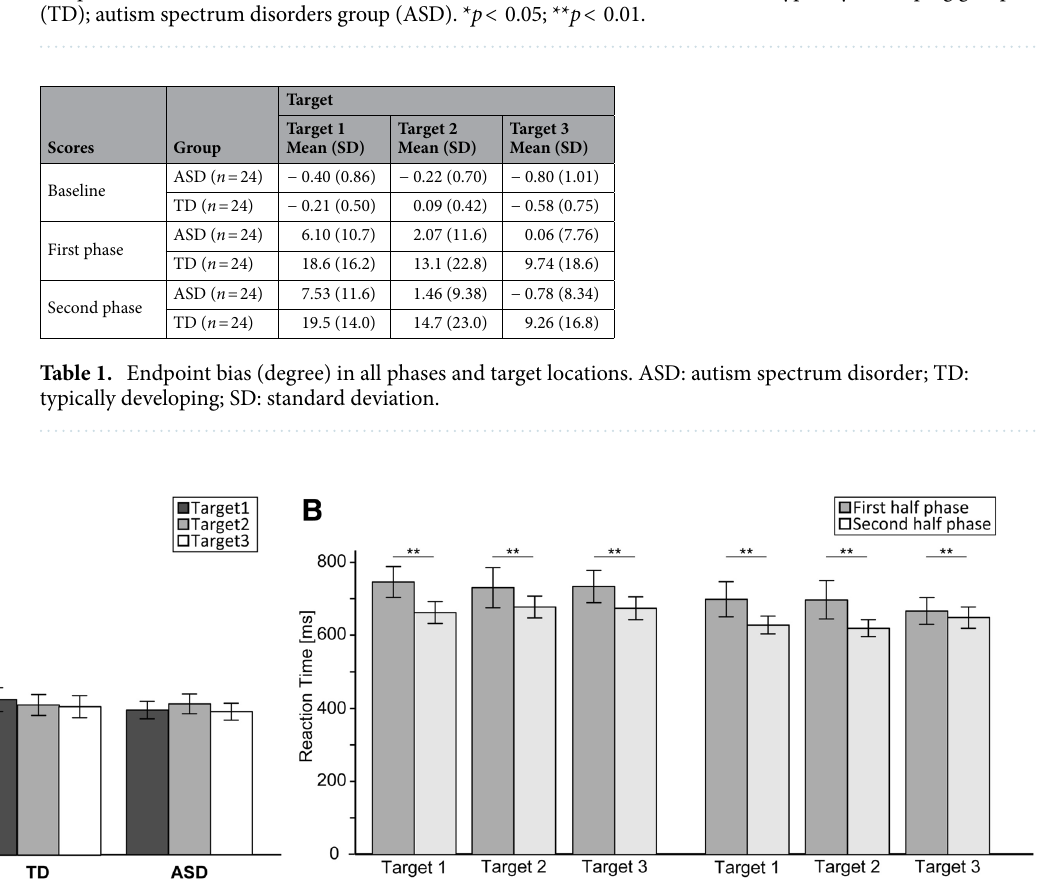
Figure 1. The endpoint bias (degree) in both the TD and ASD groups for both the Baseline task ( A ) and Perspective-transformed task ( B ). Error bars indicate standard errors of the mean. Typically developing group (TD); autism spectrum disorders group (ASD). * p < 0.05; ** p < 0.01.